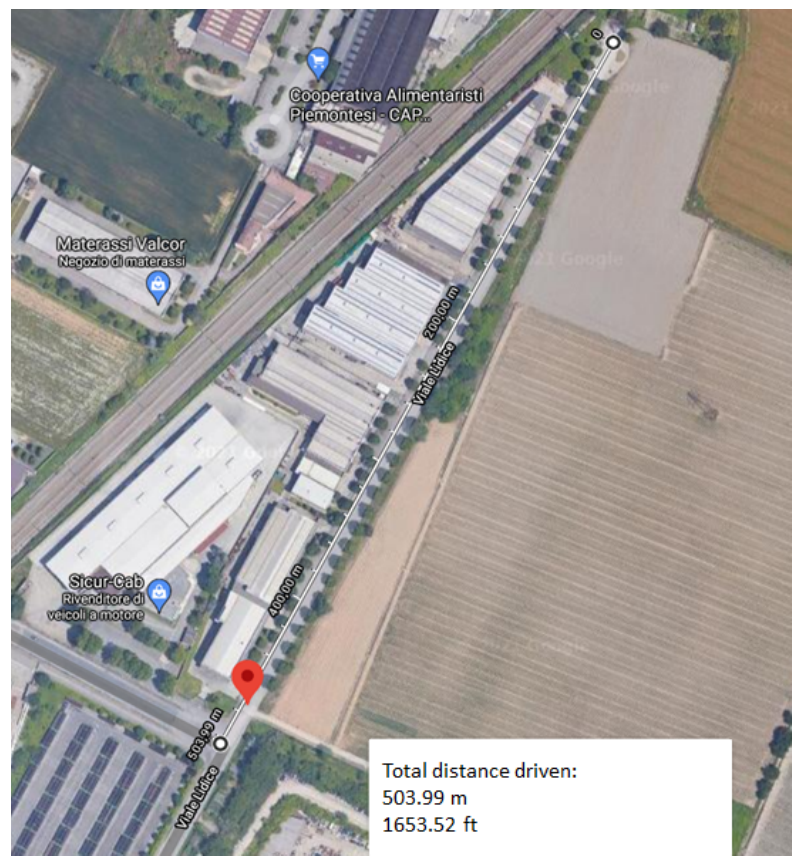
Figure 8. Selected route in Turin, Italy, forperforming on-road tests for the prototype two-wheeler. The route is driven to calibrate the dynamic vehicle